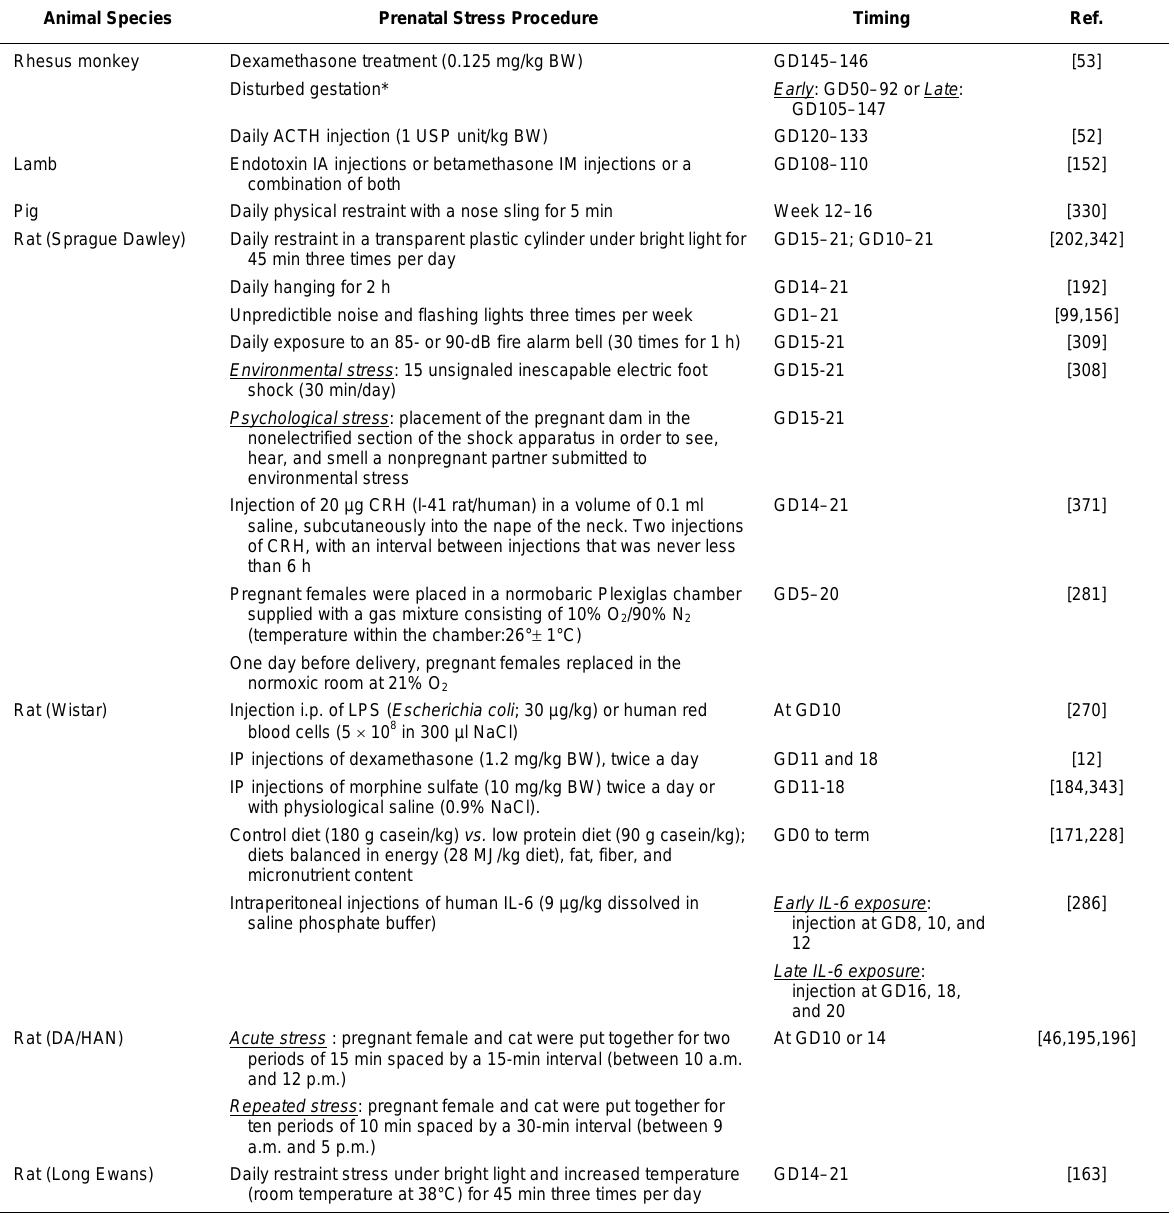
Nonexhaustive List of Different Experimental Paradigms of PS Widely Used in Several Species for Modeling PS-Induced Alterations of Human